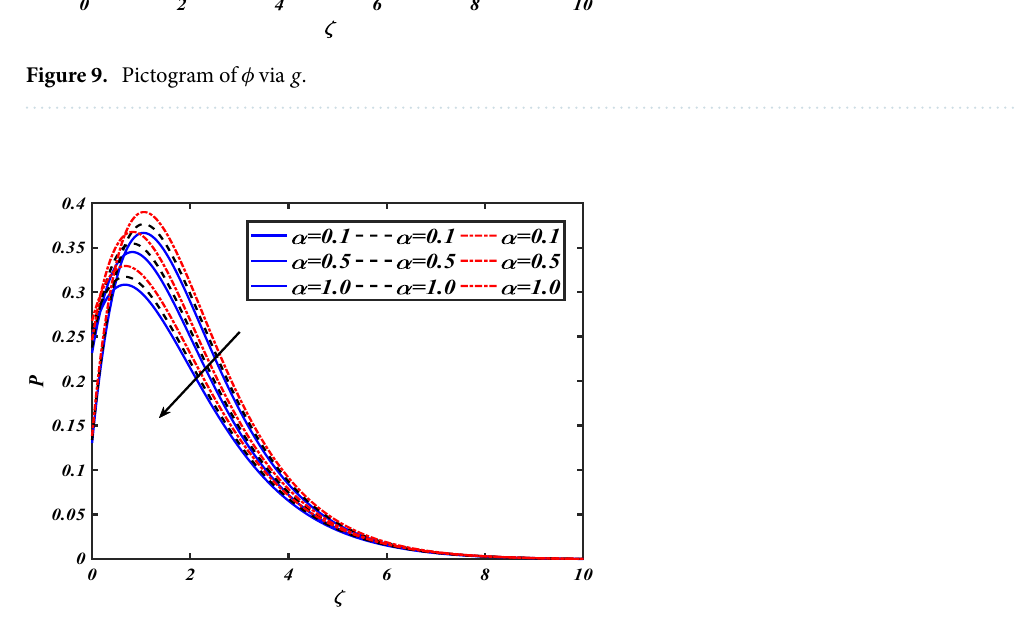
Figure 10. Pictogram of α via P